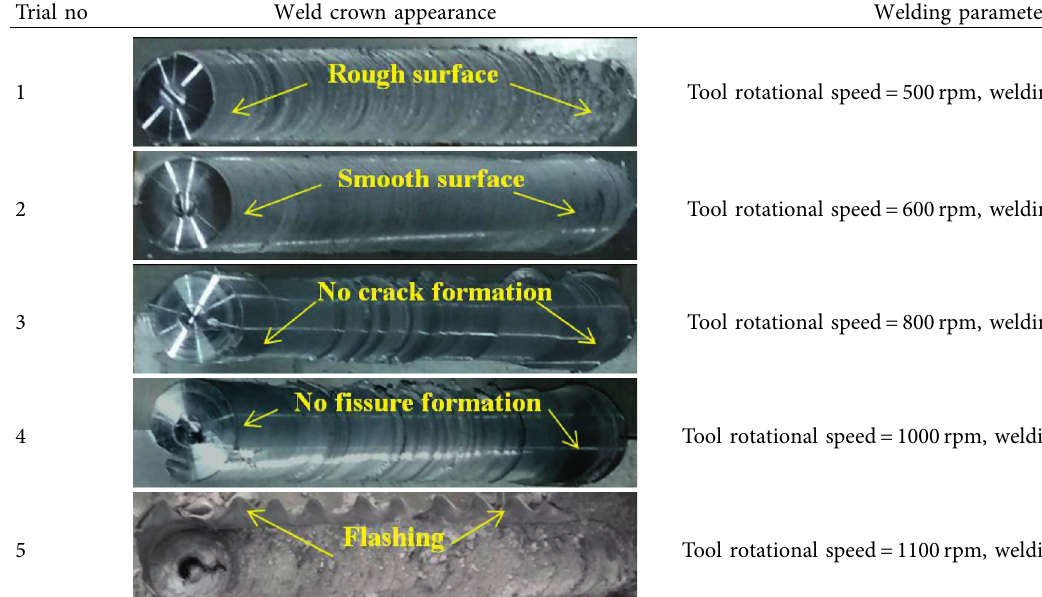
Table 4: Weld appearance during dissimilar FSW without reinforcement. Trial no Weld crown appearance Welding